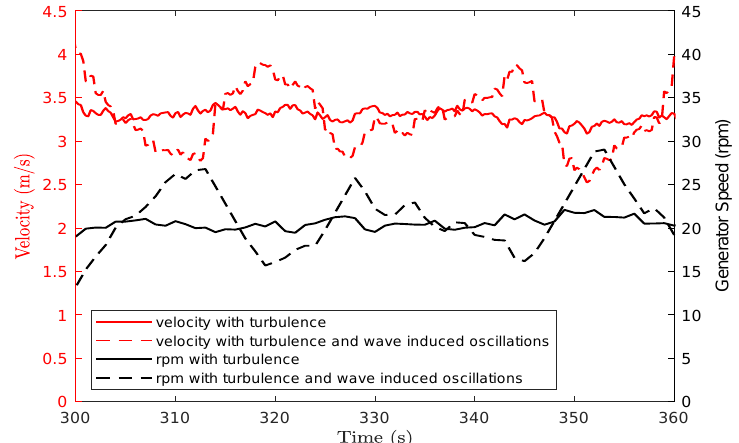
Figure 15. Active speed stall control of Generator speed as a function of change in tidal stream velocity. Mean tidal velocity in this image is set at 3.3 m/s.